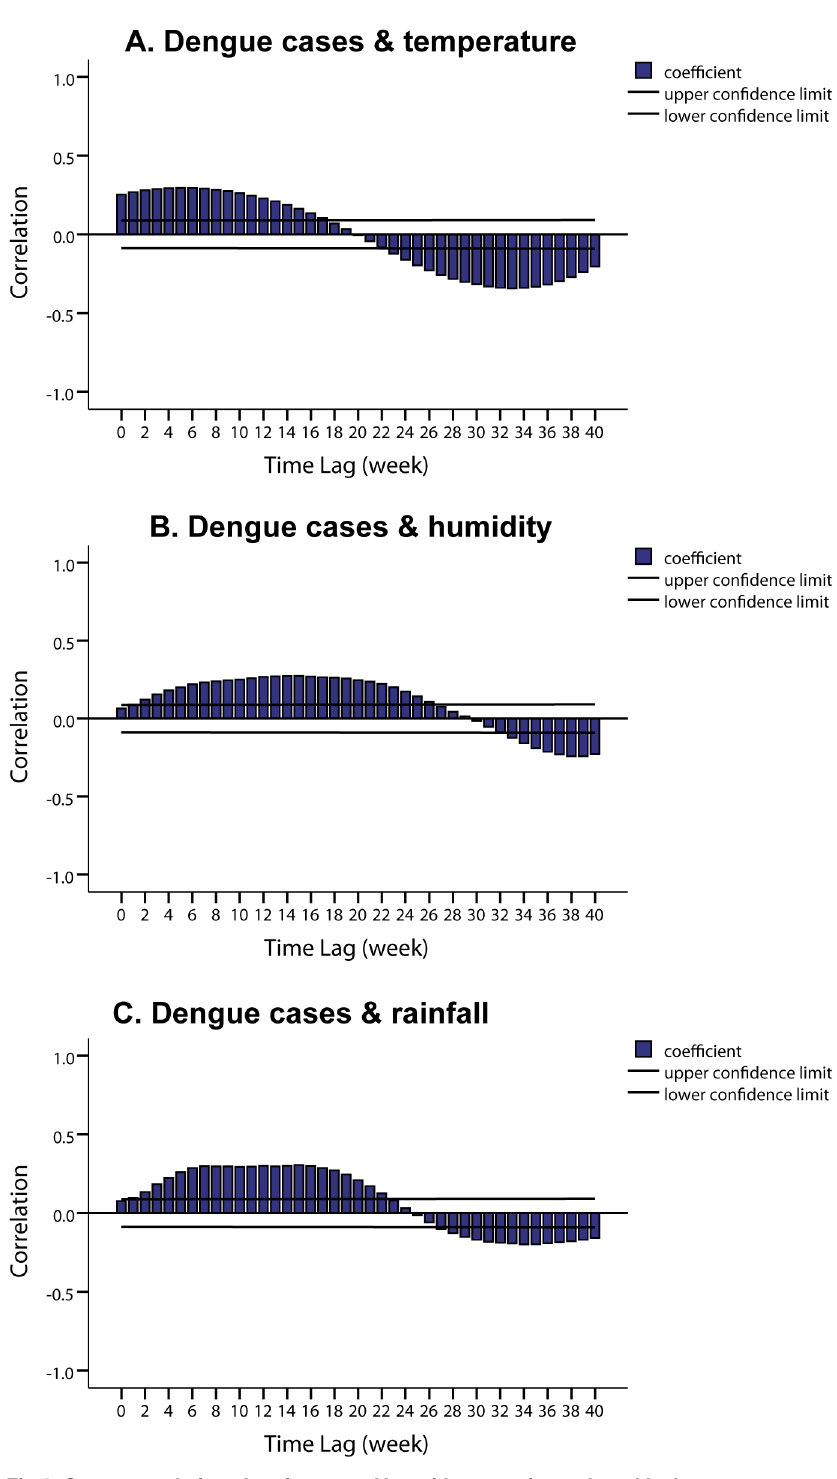
Fig 4. Cross-correlation plots for natural logarithm transformed weekly dengue case counts and different weekly meteorological factors in Zhongshan. A. Cross-correlation between natural logarithm transformed weekly dengue case counts and treated weekly average minimum temperature in Zhongshan, B. Cross-correlation between natural logarithm transformed weekly dengue case counts and treated weekly average relative humidity, C. Cross-correlation between natural logarithm transformed weekly dengue case counts and treated weekly accumulated rainfall.